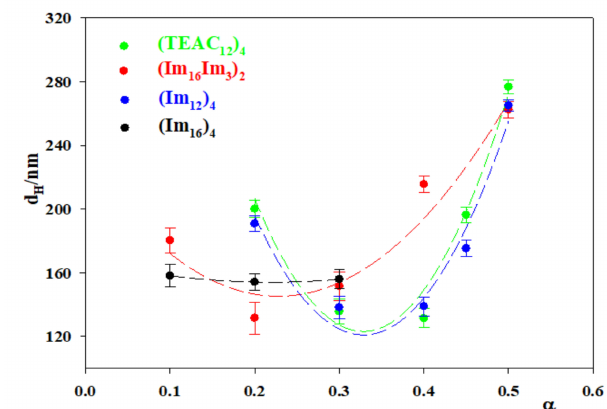
Figure 1. Dependence of the hydrodynamic diameter, d H , on the cationic calixarene molar fraction, α . T = 303.1 ± 0.1